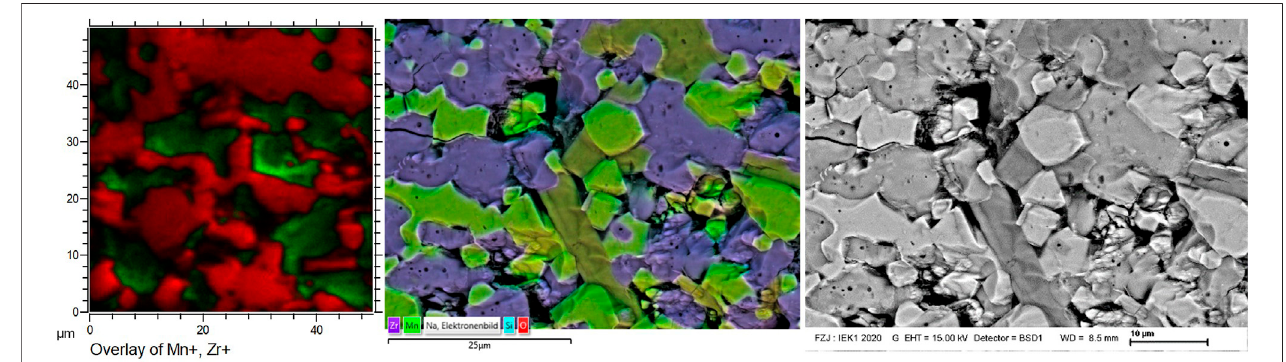
FIGURE 9 | NNFM/NZSiP co-sintered pellet. Overlay of detected elements from SIMS (left) and EDX (middle) , as well as BSE image (right)